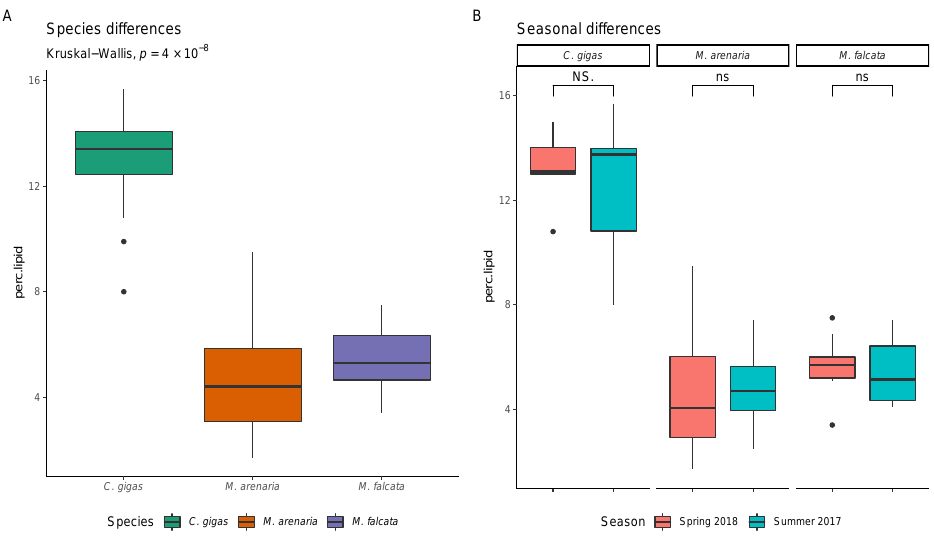
Figure 2. Lipid content of bivalve tissues varied between species ( A ) but not between seasons ( B ) for three species of bivalves that inhabit different areas of the coastal watersheds. ns = not